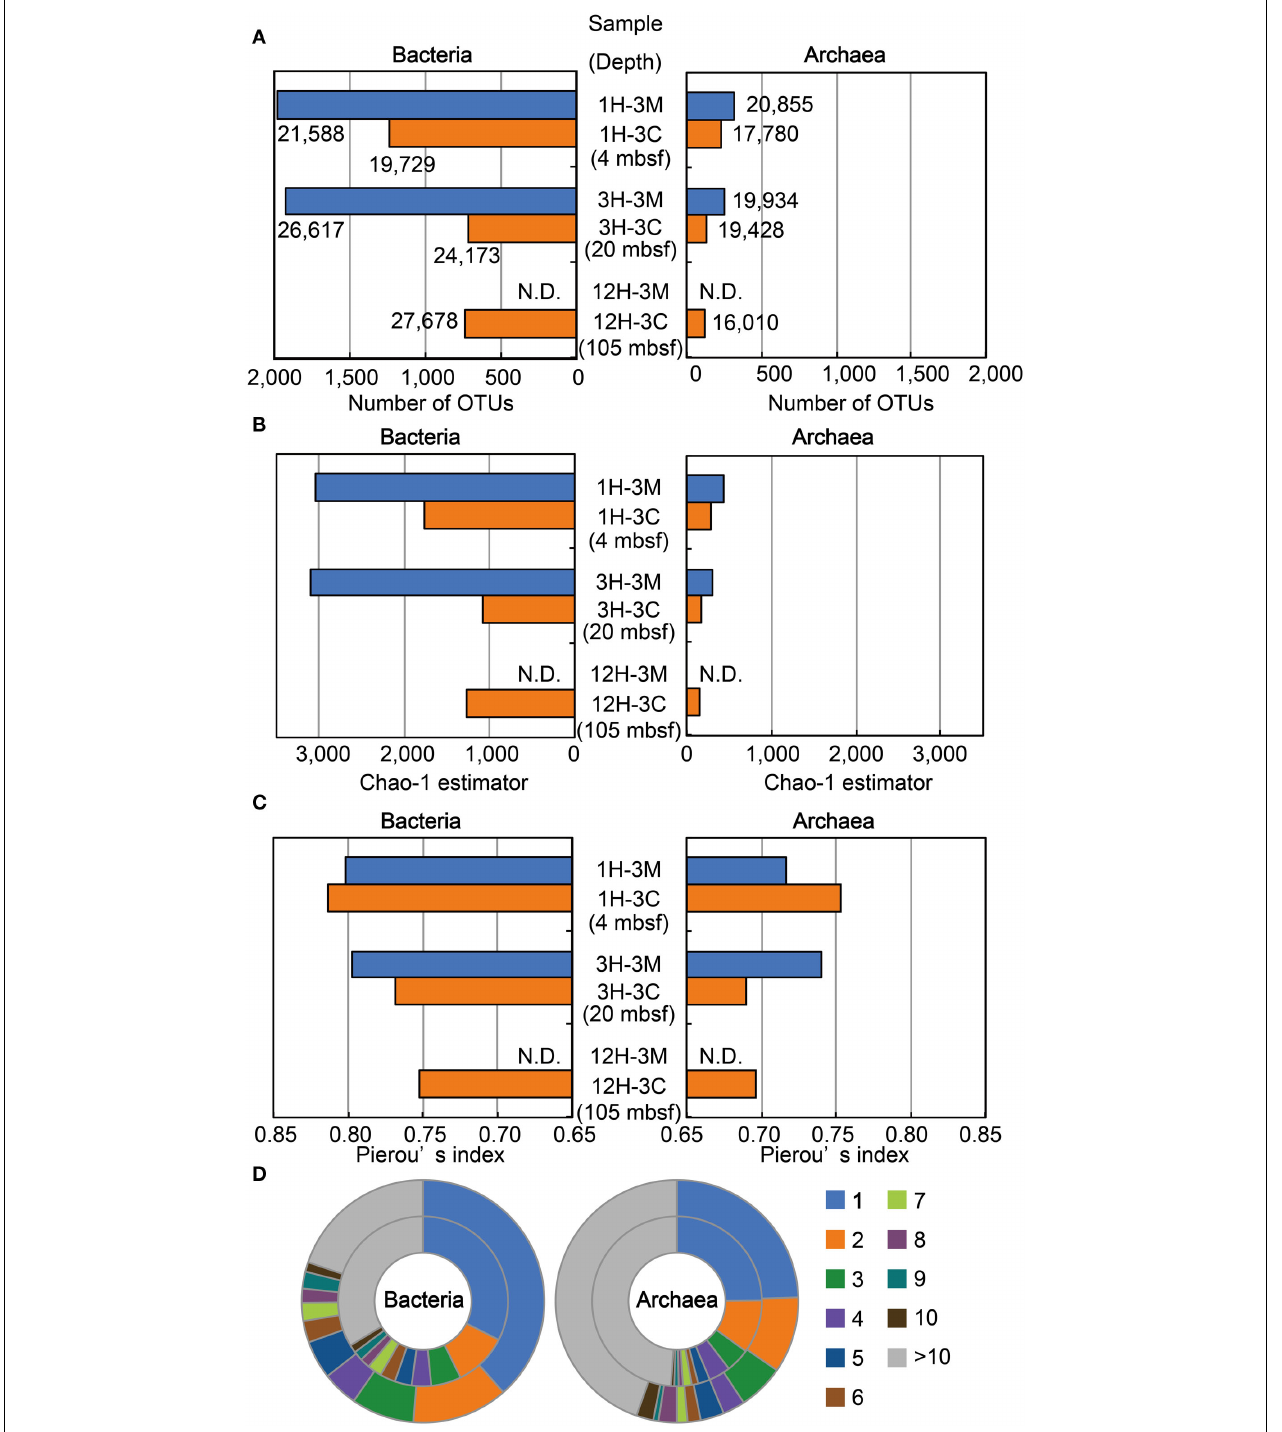
Phylotype frequency for total bacterial (left) and archaeal (right) communities. The outer and inner circles indicate the community from clay matrices and coral fossils, respectively.The number of tag sequences classified as the same phylotype (OTU) is indicated by color as shown in the right legend. Blue and orange bars in (A–C) indicate sediment matrix and coral fossil, respectively. N.D., Not